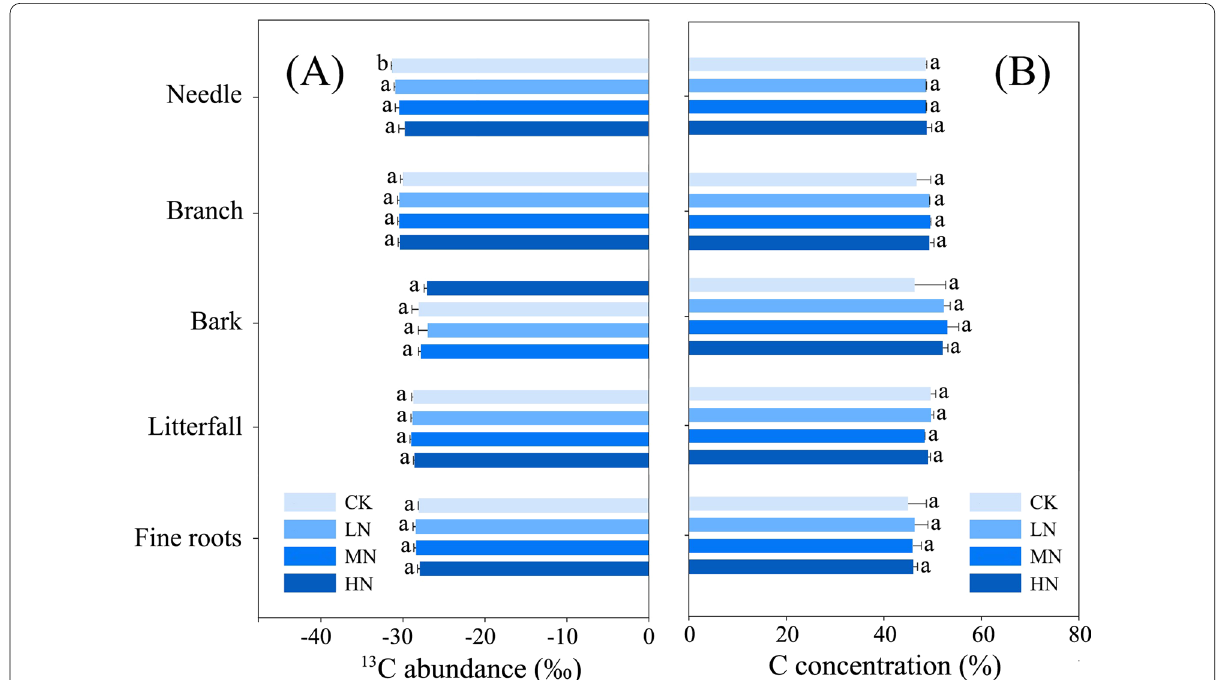
Fig. 3 Effects of nitrogen addition on δ 13 C value and C concentration of different components of Larix gmelinii . A The δ 13 C value of different components of Larix gmelinii . B The C concentration of different components of Larix gmelinii . Error bars represent 1 SE of the mean. CK, LN, MN, HN represent the control, low N treatment, medium N treatment, and high N treatment,